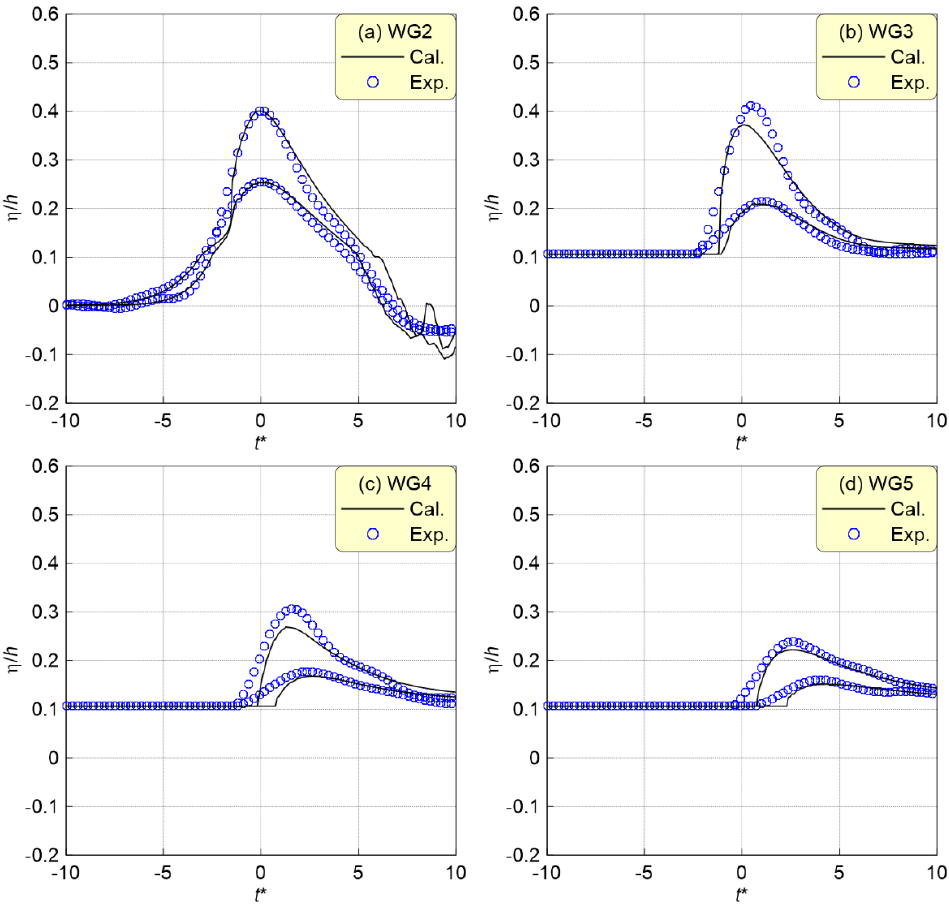
Figure 10. Comparisons of measured and calculated time-domain water surface elevations at the VR.